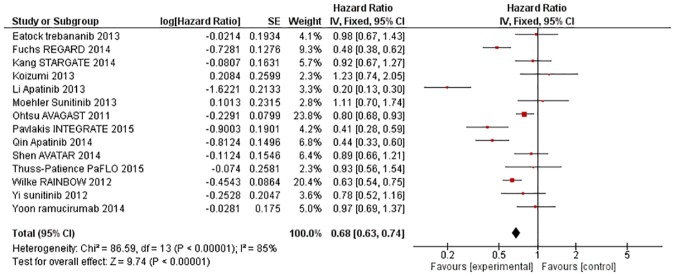
Forest plot—Progression-free Survival—all trials.